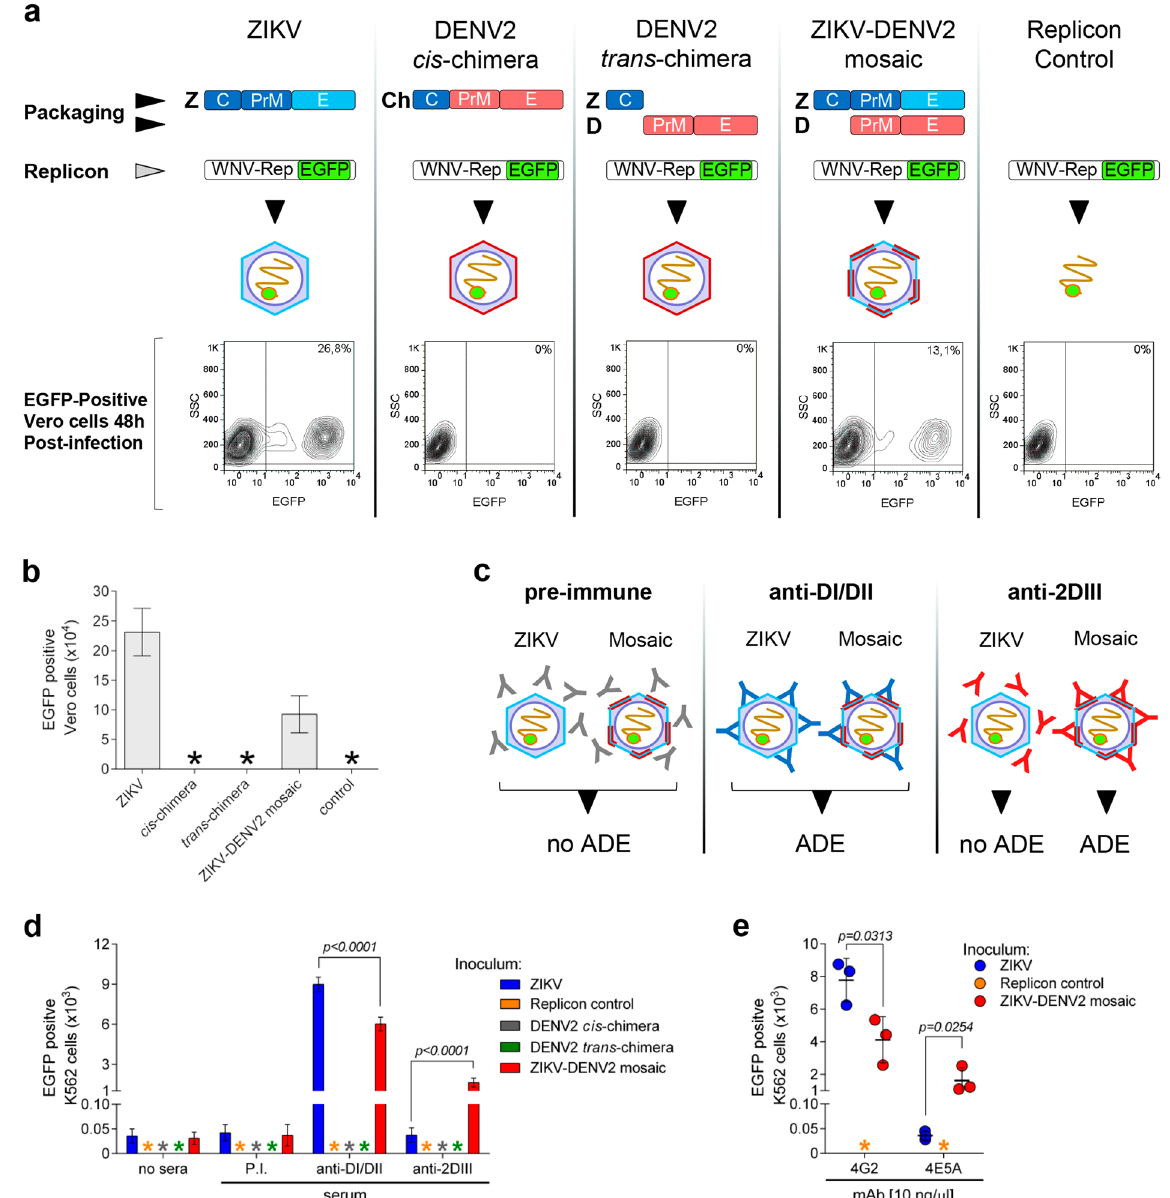
Figure 5. Assembly of ZIKV/DENV2 E protein mosaic pseudoviruses. ( a ) Pseudoviruses produced by co- transfection of the WNV replicon and different packaging constructs, were revealed by determining EGFP positive Vero cells following infection for 48 h. Percentages of EGFP positive cells on a representative sample are indicated. ( b ) Total number of infected Vero cells obtained using equal volumes of pseudoviral preparations as shown in ( a ) (for all preparations, n = 5), data is represented as mean ± s.d. ( c ) Scheme of the expected ADE activity for particles packaged with only ZIKV protein or ZIKV/DENV2 mosaic particles incubated with antibodies recognizing both, ZIKV and DENV2 E proteins (anti-DI/DII) or only DENV2 E protein (anti- 2DIII). ( d ) Plot of EGFP positive K562 cells determined by cytofluorimetry, following infection of 5 × 10 4 cells (for 48 h) with supernatants of transfections as in ( a ), and treated with anti-DI/DII (for all preparations, n = 5; t = 8,868 df = 8), anti-2DIII (for all preparations, n = 5; t = 10,70 df = 8) or control antibodies ( n = 5). ( e ) Plot of EGFP positive K562 cells determined by cytofluorimetry, following infection of 5 × 10 4 cells (for 48 h) with supernatants of transfections as in ( a ), and treated with mAb 4G2 (10 ng/ μ l) ( n = 3; t = 3,252 df = 4) or mAb 4E5A (10 ng/ μ l) ( n = 3; t = 3,478 df = 4). In all cases equal volumes of inoculum were used to infect cells, data is represented as mean ± s.d. * ,